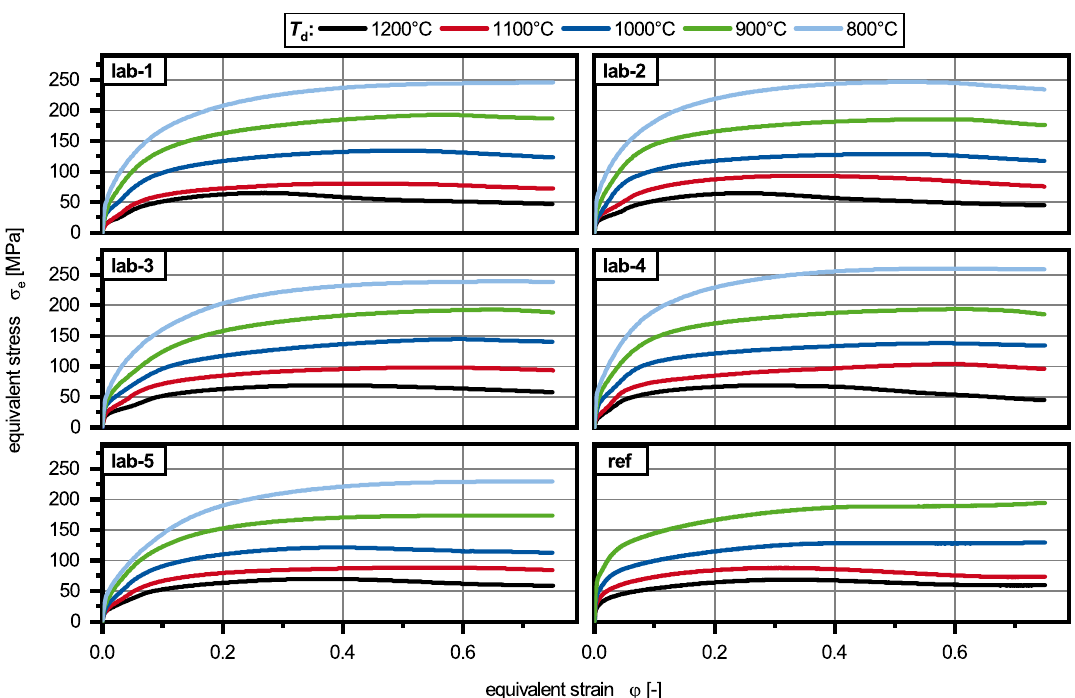
Figure 5. Influence of the deformation temperature on the flow curves of alloys lab-1 to lab-5 and the reference alloy (ref).